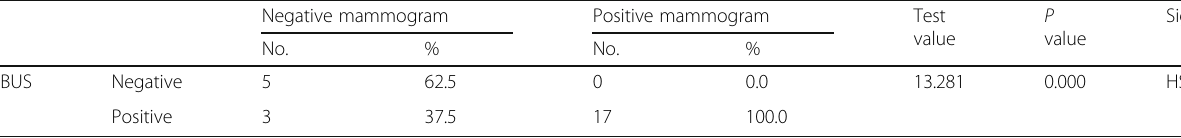
Table 6 Comparison between detected positive and negative lesions by mammogram and